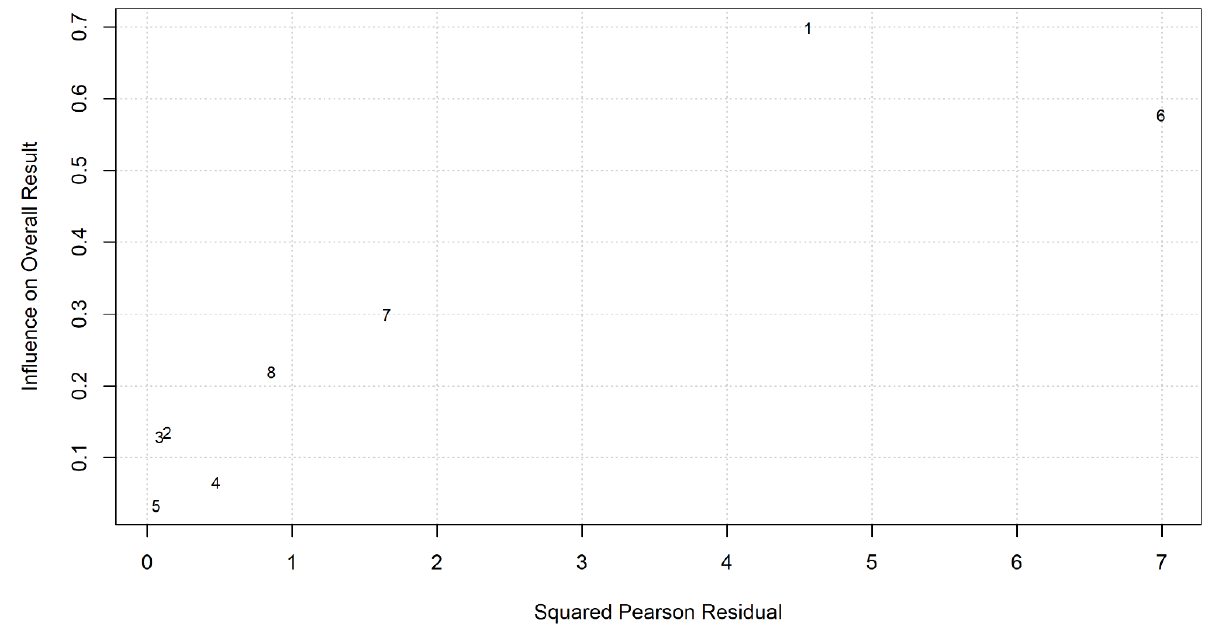
Figure 3. Baujat plot inspection.